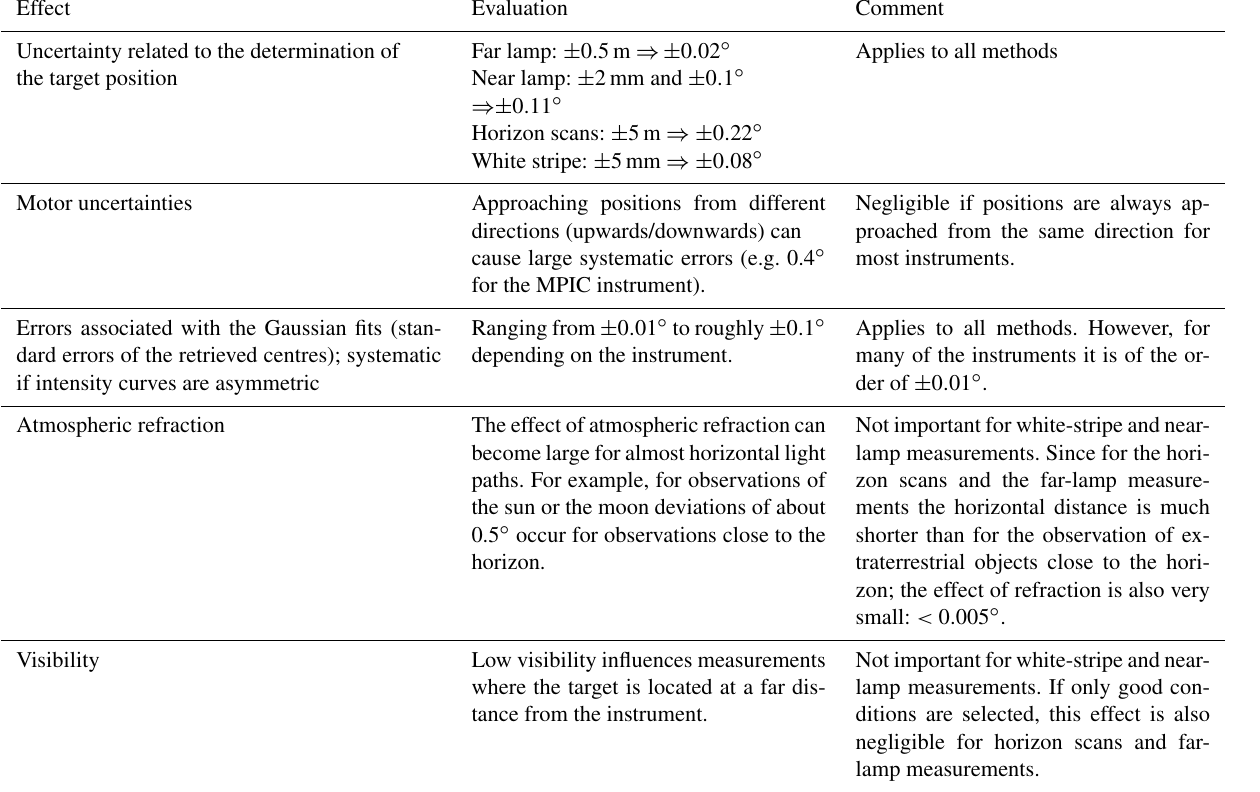
Table A1. List and evaluation of systematic effects influencing the measurements presented in this